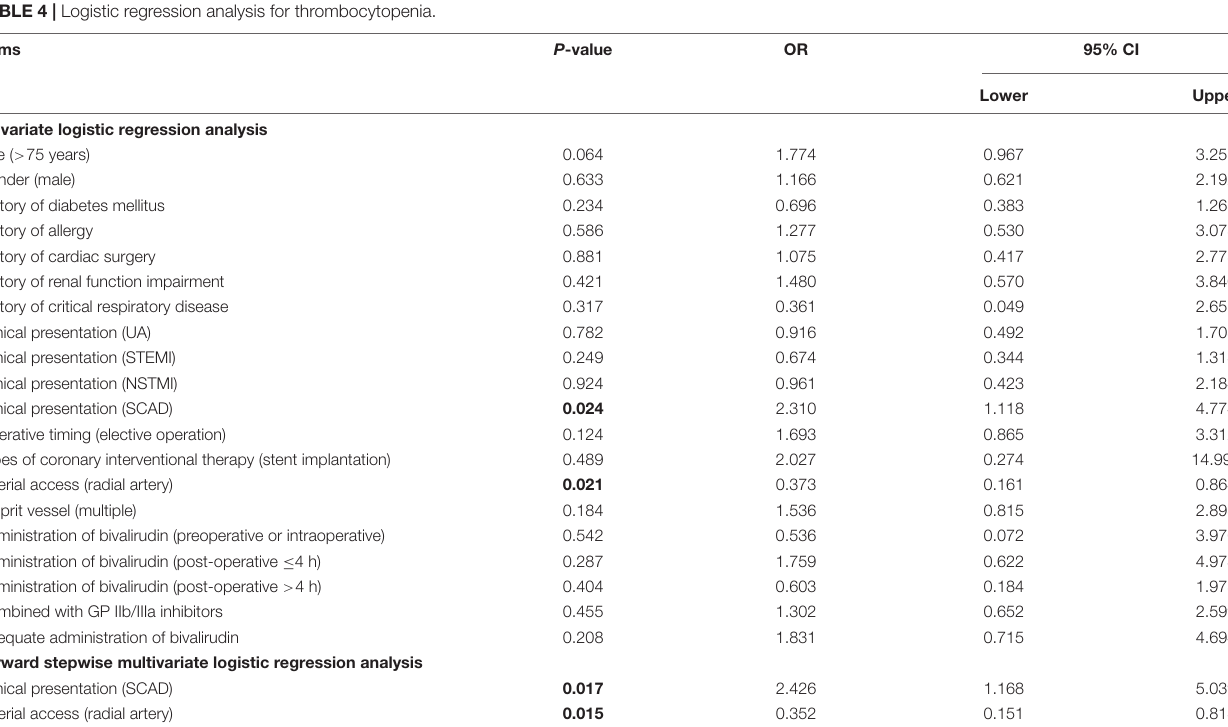
TABLE 4 | Logistic regression analysis for